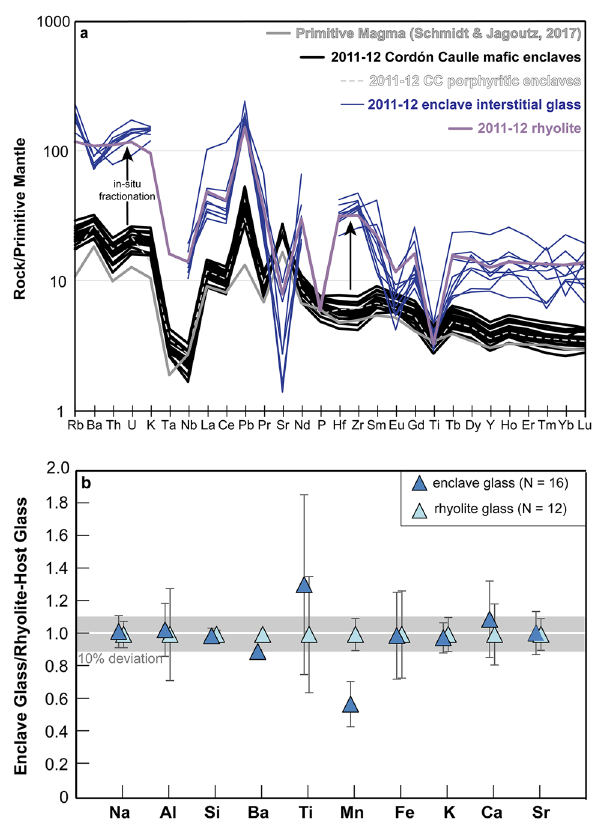
Figure 5. ( a ) Incompatible trace element spider diagram (XRF + ICP-MS data) normalized to primitive mantle 63 . Grey line: representative primitive magma 32 . Black line: 2011–12 CC coarsely-crystalline mafic enclaves. Dashed light grey line: 2011–12 CC porphyritic enclaves. Thin dark purple line: 2011–12 mafic enclave interstitial glass data (LA-ICP-MS). Light Purple: 2011–12 host rhyolite (XRF + ICP-MS). Arrows indicate symmetrical elevation of rhyolite data from mafic enclaves suggestive of in-situ fractionation. ( b ) 2011–12 CC mafic enclave interstitial glass normalized to host rhyolite glass and display overlapping compositions. Symbols are the same as Fig.